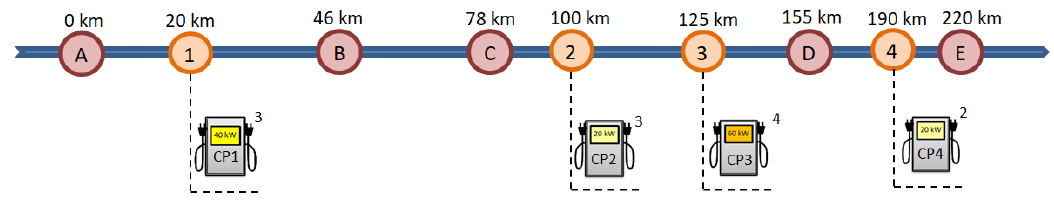
Figure 3. Example of a motorway infrastructure in model II with b 1 = 3, b 2 = 3, b 3 = 4, b 4 =